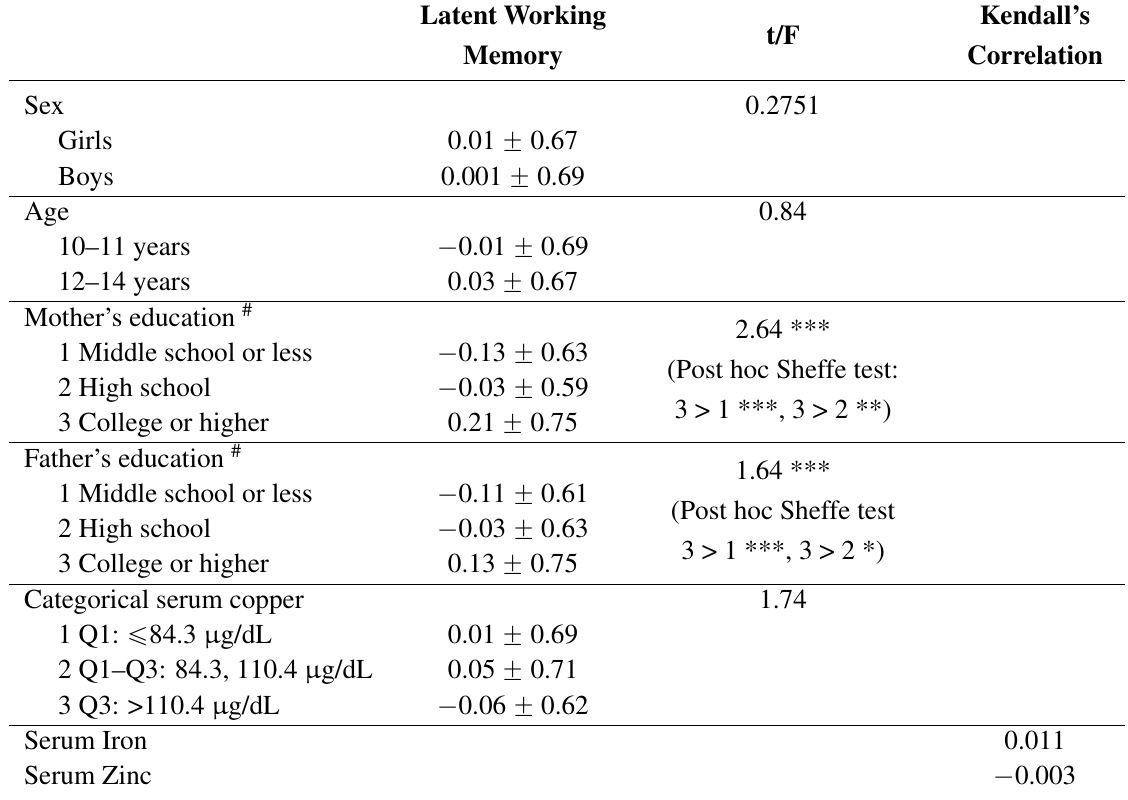
Figure 1. The confirmatory factor analysis of working memory using structural equation modeling. Numbers on each path from latent variable (Working Memory) to the observed variables represent standardized factor loading (standard error). Numbers on the arrows from the error terms (e) to the observed variables represent covariance of error terms. Numbers on the bottom represent the correlation between the two error terms. *** p < 0.001. Table 2. The relationship between sociodemographic characteristics and latent working memory.